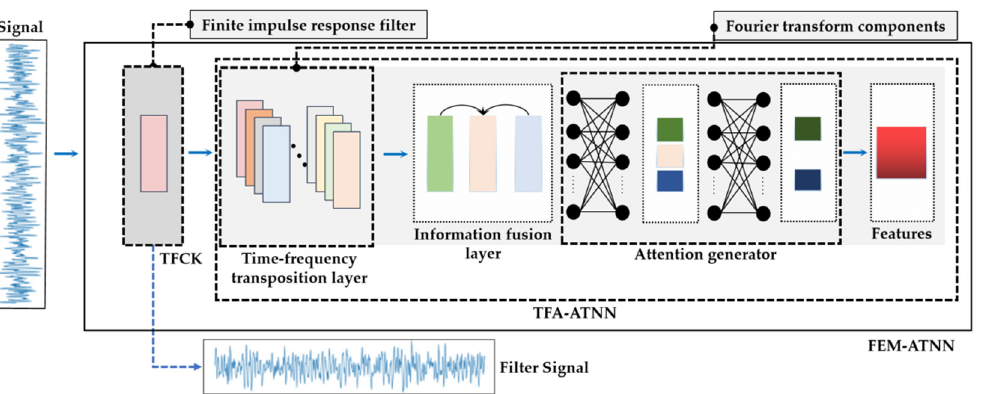
Figure 1. A brief description of the method in this paper: firstly, TFCK is used to filter the raw signal; secondly, a set of convolution kernels are adopted to extract the time-frequency feature from the filtered signal; finally, an attention-based network is conducted to